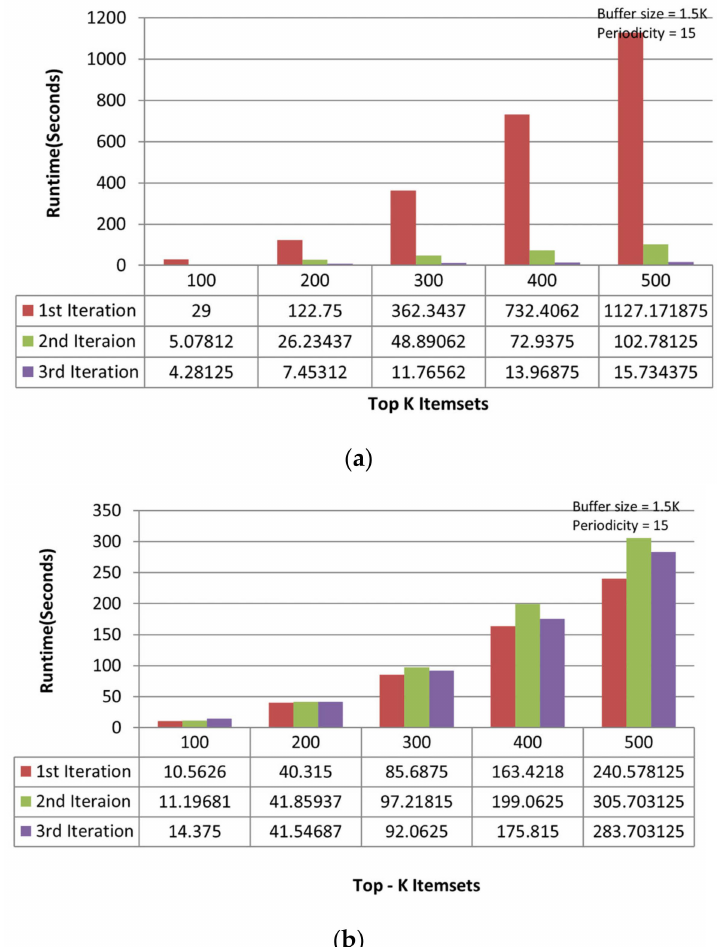
Figure 8. ( a ) Results of three iterations of TKIFRPM on the chess dataset. ( b ) Results of three iterations of MTKPP on the chess